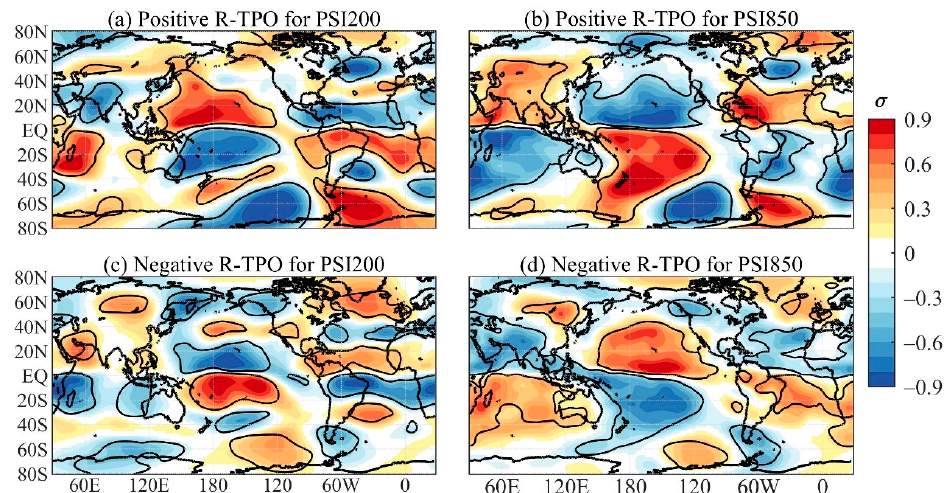
Figure 5. Composites of the residual zonally asymmetric streamfunction anomalies during austral spring for the: ( a ) positive R-TPO and PSI200; ( b ) positive R-TPO and PSI850; ( c ) negative R-TPO and PSI200; and ( d ) negative R-TPO and PSI850. In this Figure, residual means without the IOD effects. Continuous contours encompass significant values at a 95% confidence level using the Student’s t -test.